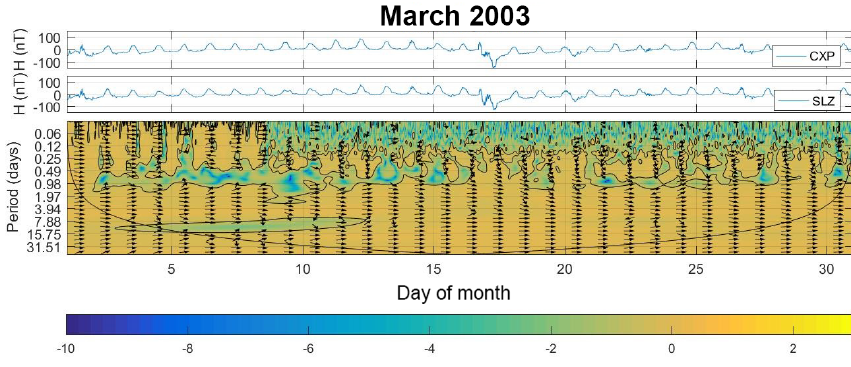
Figure 5. The same as Fig. 4 but for CXP and SLZ,